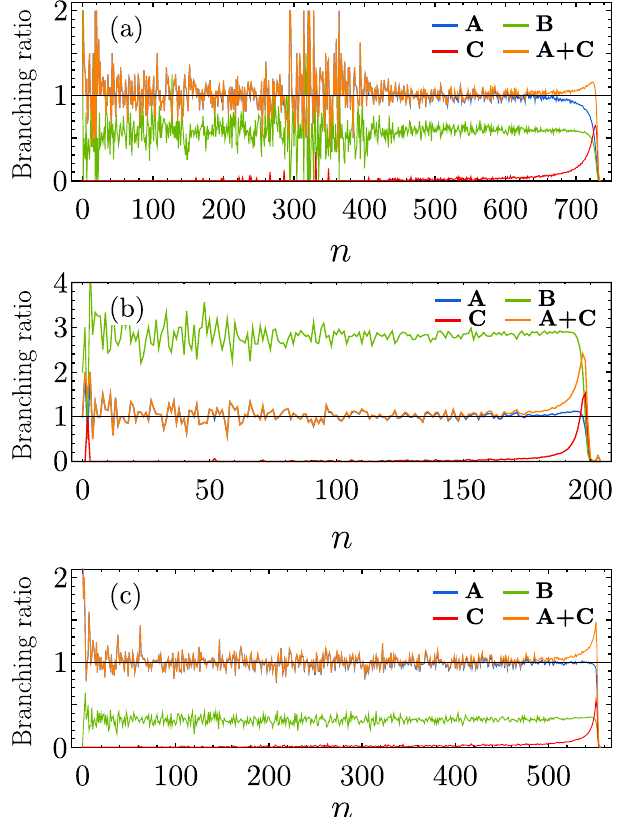
Figure 4. Evolution of each reaction type for several models. ( a ) For k -core percolation with k = 3, plot of the branching ratios as a function of generation n for each type of reactions during an infinite avalanche. A represents the ratio of removed nodes with original degree z = 3 ( z > 3), which corresponds to the reaction S + I → 2 I for the SWIR model. B does the ratio of the reaction W k − l > 0 + I → W + I , which corresponds to the ratio of generating weakened nodes denoted by W . C does the ratio of nodes changing their degrees to z = k = 3 ( W + I → 2 I ). A + C represents the total branching ratio of I . Data are obtained from a network with N = 5.12 × 10 6 at a transition point. ( b ) For the threshold model, a similar plot. A and B represent the mean number of I and W offsprings generated by the reactions S + I → 2 I and + → + , respectively. C − W I W I kq m i i i does the ratio of nodes of I by the reaction corresponding to W + I → 2 I . The sum of the mean I offspring from A and C represents the total branching ratio of I . Data are obtained from a network with N = 5.12 × 10 6 at a transition point. ( c ) For the CF model, a similar plot. A represents the ratio for S + I → 2 I . B is the mean number of new W -state nodes ( k A or k B becomes unity for the first time). C is the mean number of I -state nodes transformed from W nodes ( W + I → 2 I ). A + C represents the total branching ratio of I . Data are obtained from a network with N = 5.12 × 10 6 at a transition